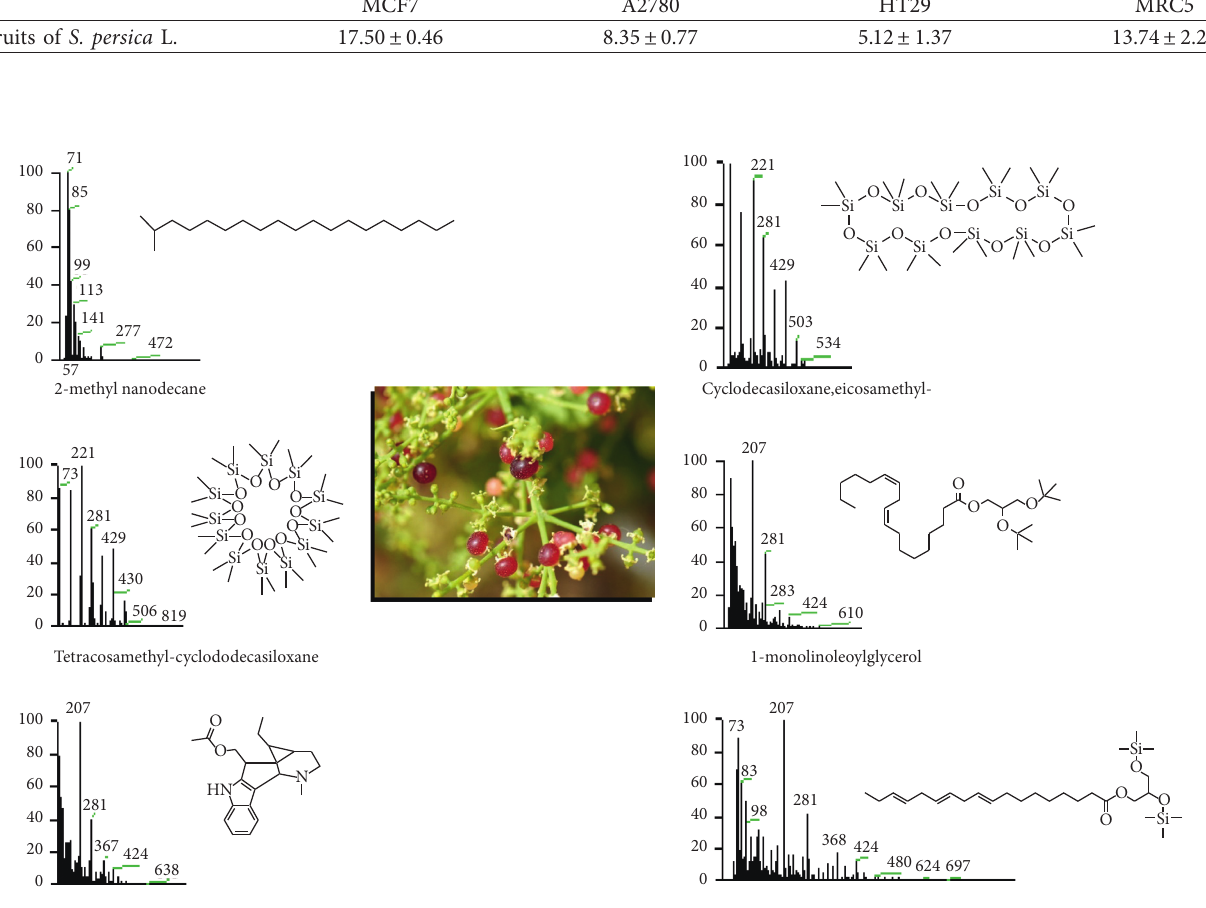
Figure 3: Major bioactive components detected in S. persica fruits using GC-MS.